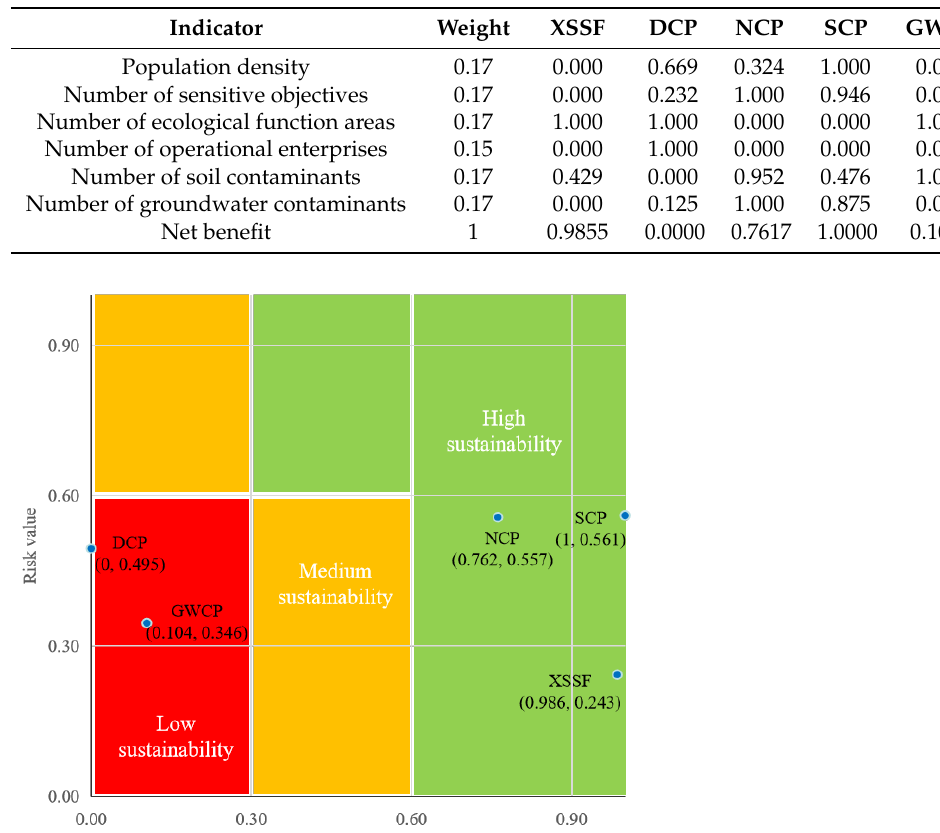
Table 4. The standardized data and weights of the evaluation index.